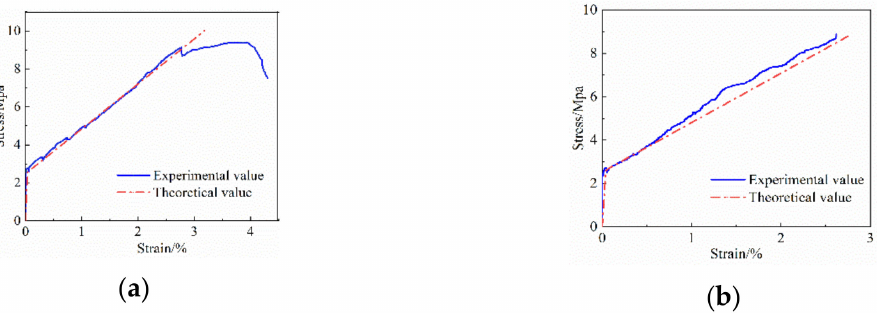
Figure 12. Comparison of stress–strain test values and theoretical values of the FRP grid-reinforced ECC composite specimens. ( a ) Specimen E1C2-2, ( b ) Specimen